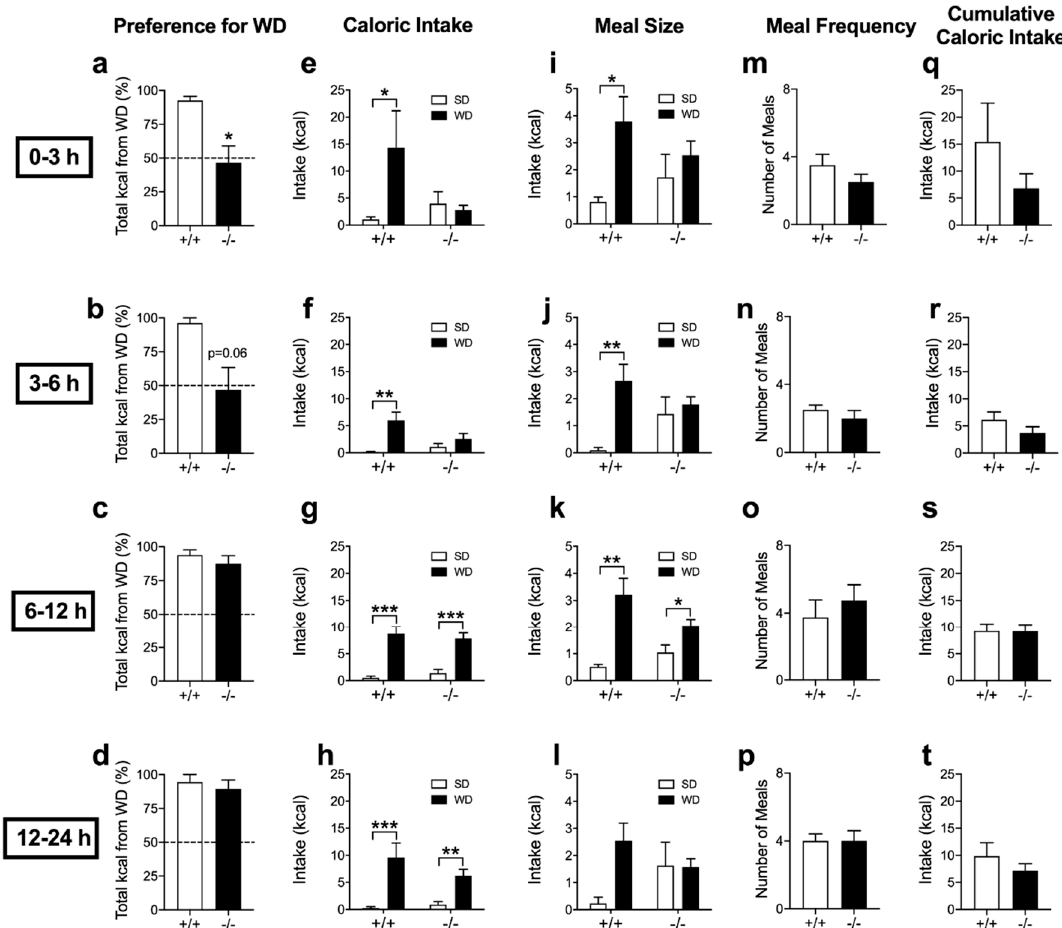
Figure 5. Acute preferences for western diet are absent in conditional intestinal epithelium-specific CB 1 R-deficient mice. +/+ = IntCB 1 +/+ control mice; − / − = IntCB 1 − / − mice; SD = standard rodent chow; WD = western diet. Unpaired Student’s t -test, two-tailed ( a – d , m – t ); Two-way ANOVA with Holm-Sidak’s multiple comparison tests ( e – l ); * = p < 0.05, ** = p < 0.01, *** = p < 0.001. Results are expressed as means ± S.E.M; n = 4–8 per condition.